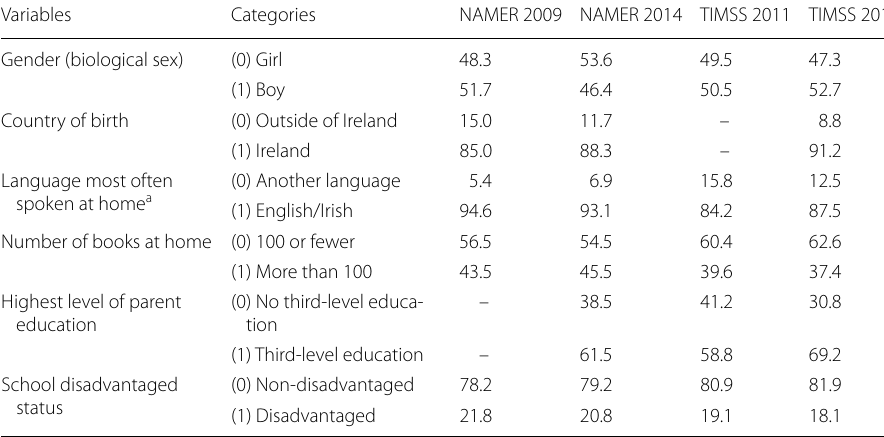
Table 2 Demographic features of the samples